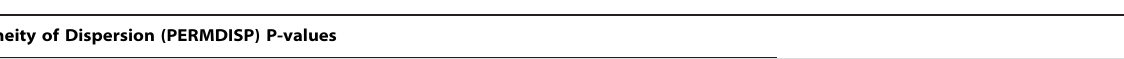
Table 2. Post-treatment + NP communities showed differences from all reference succession communities with the exception of the oldest transect (P , 0.05).